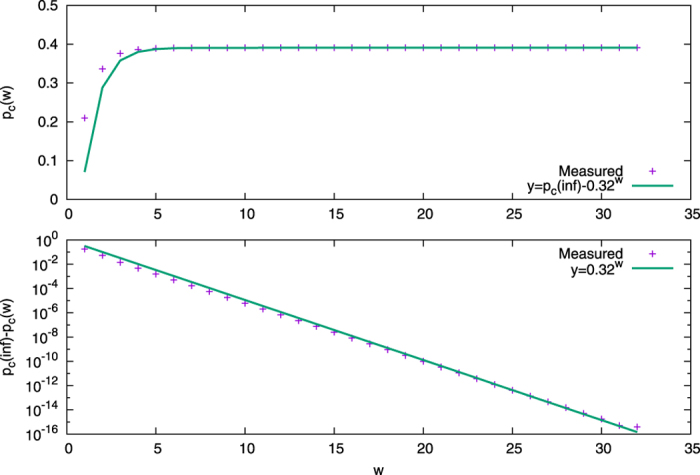
The critical value function of the increasing commitment naming game.The top plot shows critical values of the fraction of committed agents with different commitment strengths. The bottom plot shows the differences between pc(w) and pc(∞). Both plots shows our function fits data well.